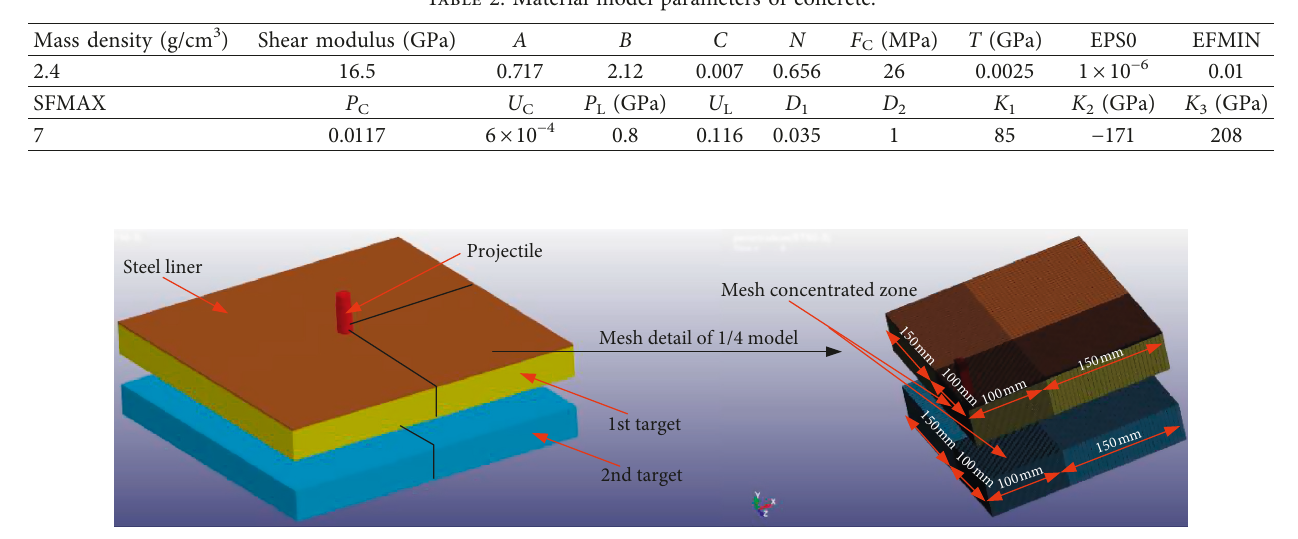
Figure 8: FEM model of projectile and segmented target